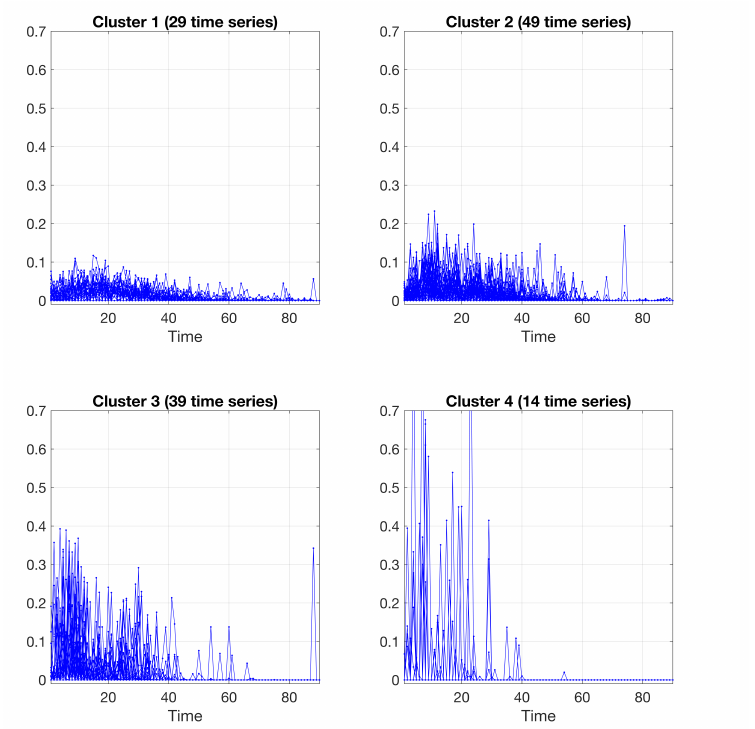
Figure 4. Clustering results obtained by the spline regression model, using a cubic B-spline; 29 time series in cluster 1, 49 time series in cluster 2, 39 time series in cluster 3, and 14 time series in cluster